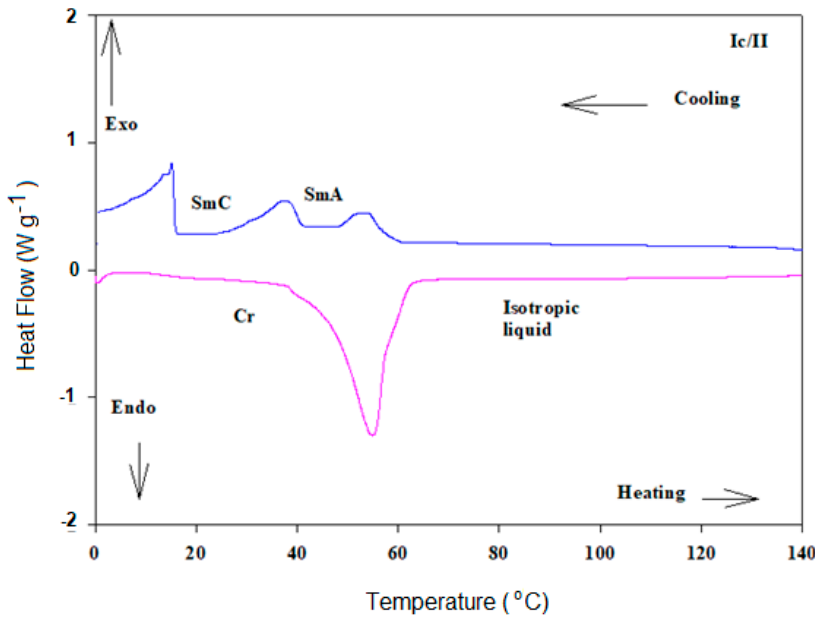
Figure 3. DSC thermograms of second heating/cooling rounds of Ic/II complex at heating rate 10 °C min − 1 .